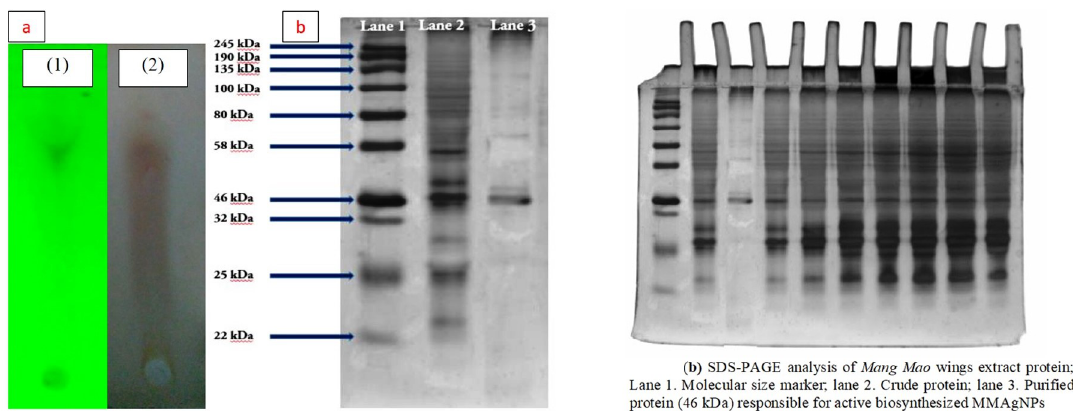
Fig 6. (a) TLC of Mang Mao wings extract: (1) UV visualization, (2) Ninhydrin reagent. (b) SDS-PAGE analysis of Mang Mao wings extract protein; Lane 1. Molecular size marker; lane 2. Crude protein; lane 3. Purified protein (46 kDa) responsible for active biosynthesized